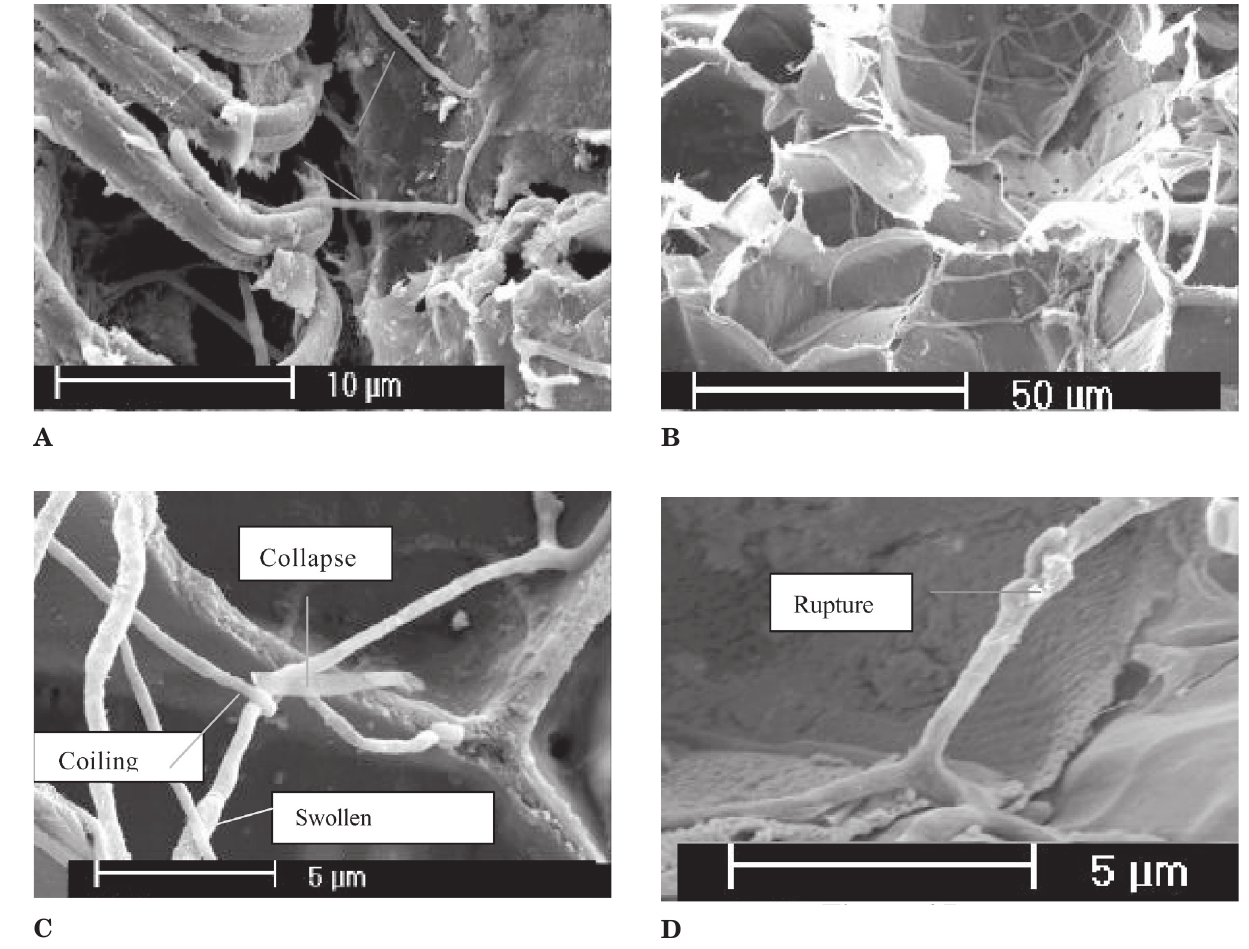
C Fig. 6. SEM of cuttings simultaneously inoculated with spores of E. lata and T. harzianum . Arrows indicate healthy hyphae. A. Turgid hyphae in cutting treated with E. lata alone. B. Healthy hyphae of T. harzianum in pith parenchyma in cutting treated with T. harzianum alone. C. Coiling, abnormal swelling and collapse of hy- phae in co-inoculated cutting. D. Rupture and collapse of hyphae in co-inoculated cutting.